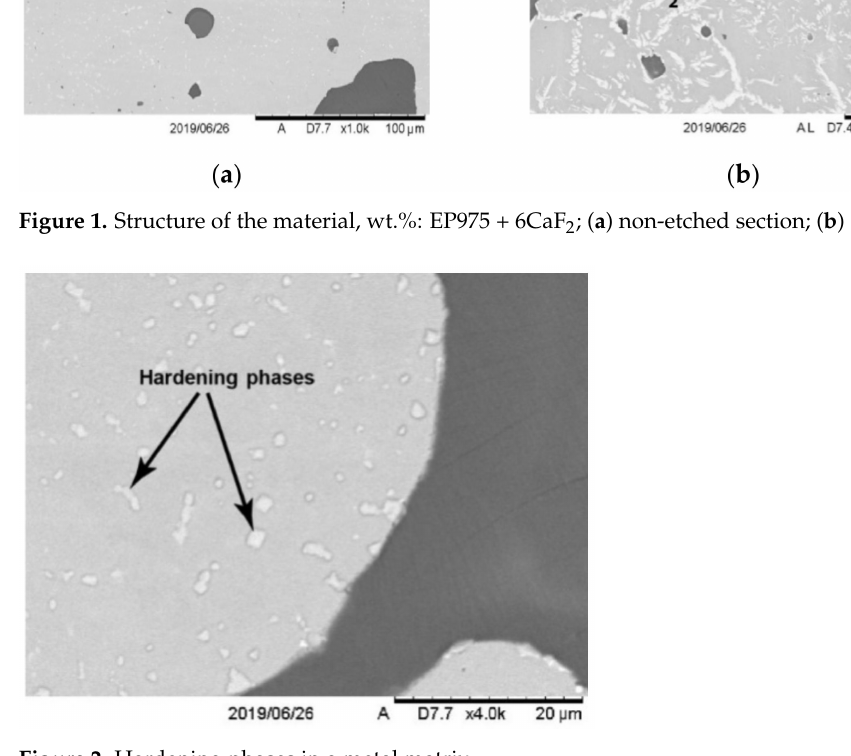
Figure 2. Hardening phases in a metal